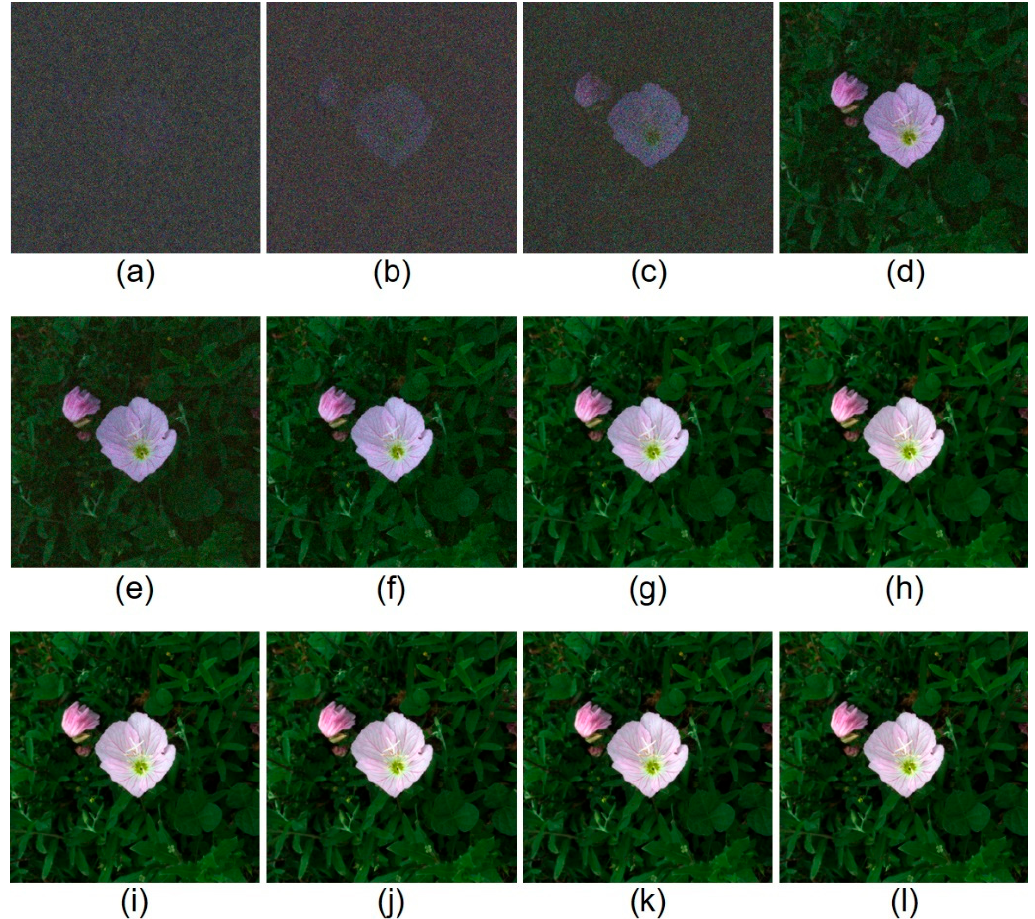
Figure 6. Numerical results concerning wavelength resolution in relation to the bit depth of an image sensor. Reconstructed images when ( a – d ) 8-bit, ( e – h ) 12-bit, and ( i – l ) 16-bit image sensors were used. Wavelength differences are ( a , e , i ) 0.5 nm, ( b , f , j ) 1 nm, ( c , g , k ) 2 nm, and ( d , h , l ) 8 nm.